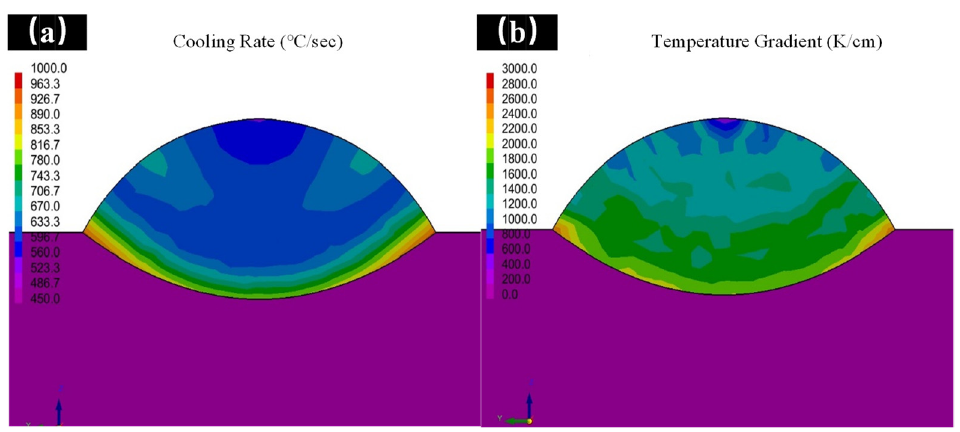
Figure 10. ( a ) Cross-sectional contours of cooling rate V n ; ( b ) cross-sectional contours of temperature gradient G .